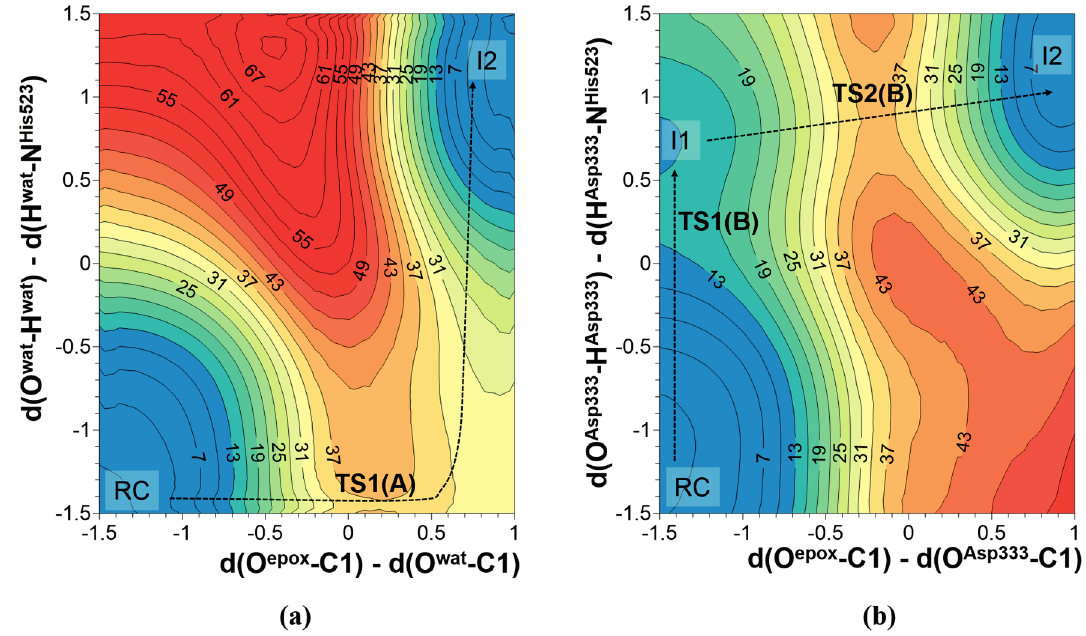
Figure 2. AM1 PES of nucleophilic attack to C1 of t-DPPO(1) by ( a ) a water molecule; and ( b ) Asp333. Distances are in Å and values on iso-energetic lines in kcal·mol − 1